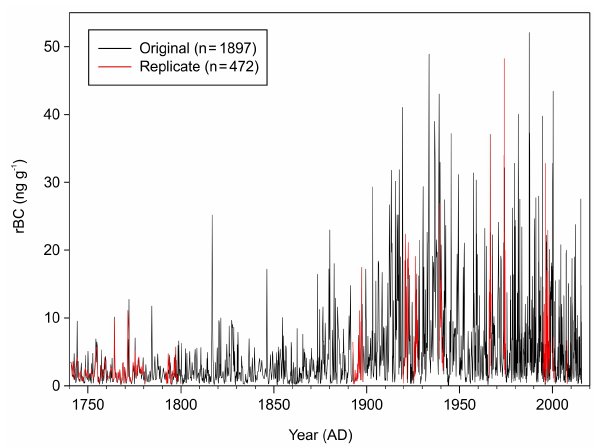
Figure 2. Combined (CG03 and CG15) Colle Gnifetti rBC con- centration record including the original analysis (black) and repli- cate samples from parallel core sections (red) between AD1741 and